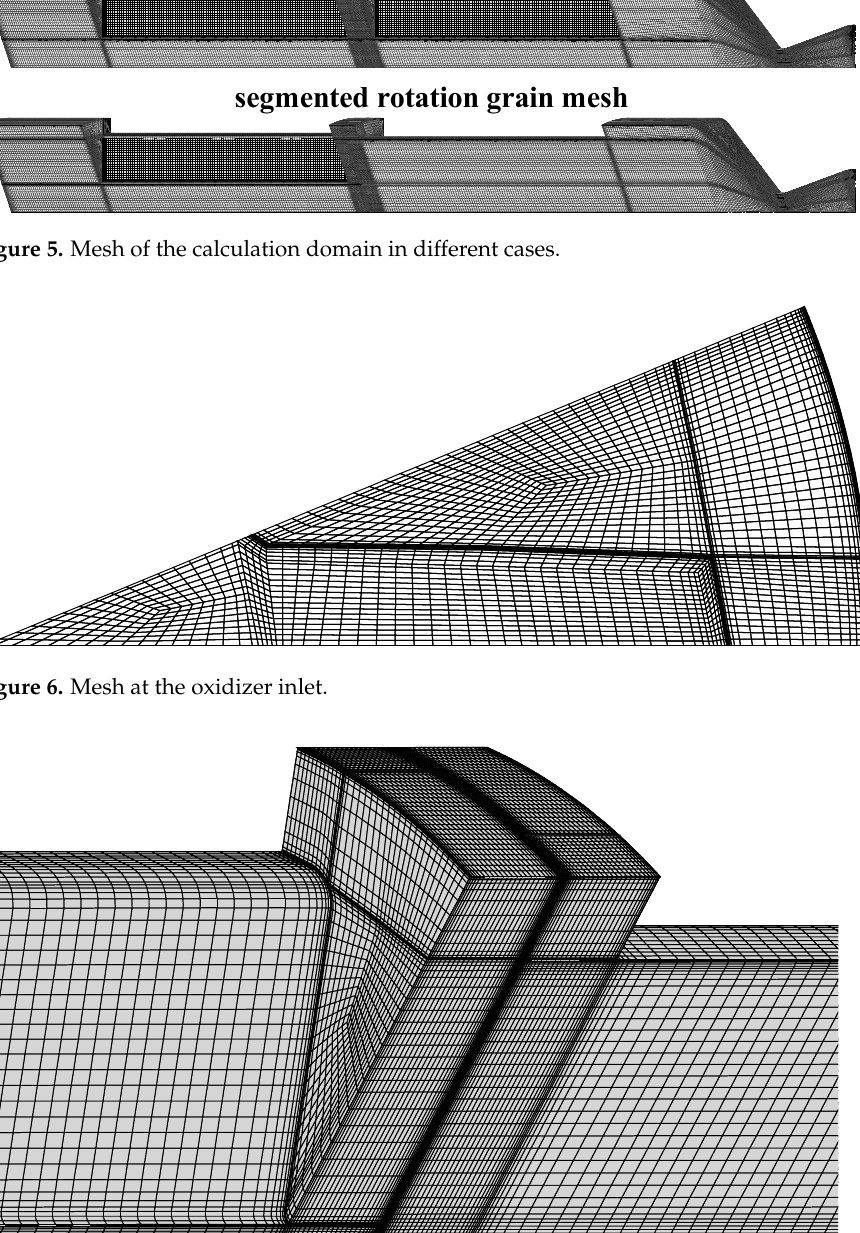
Figure 7. Mesh at the mid-chamber.